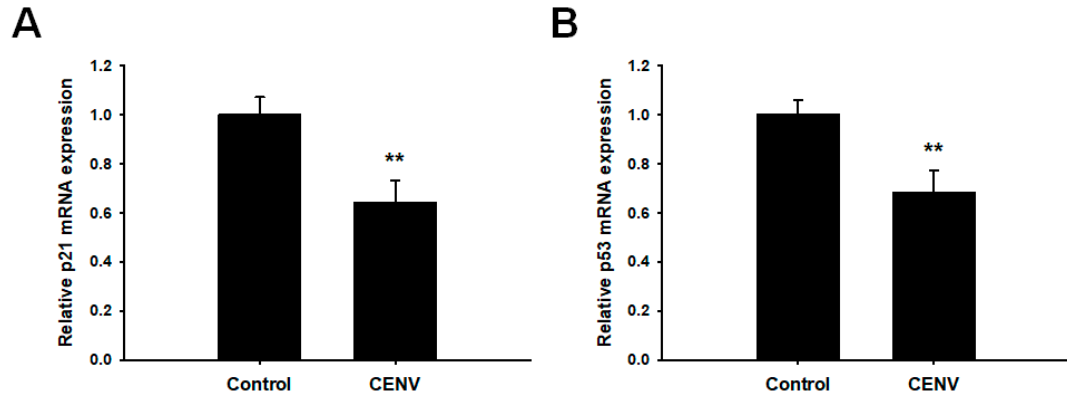
Figure 7. Quantitative analysis of ( A ) p21, and ( B ) p53, expression in senescent HDFs. The mRNA expression levels for each gene were analyzed by quantitative real-time PCR. Each mRNA sample was obtained from senescent HDFs treated with particle number 2 × 10 9 / mL of iPSC-CENVs for 48 h and non-treated cells, respectively. Statistical significance (** p < 0.01 compared to the non-treated control) was determined using Student’s t -test. Error bars indicate the standard deviation of triplicate experiments.